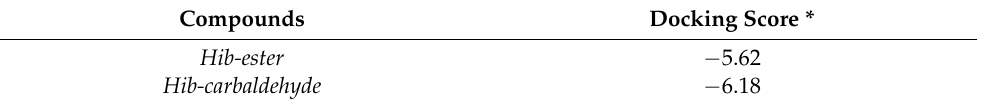
Table 1. Docking score values calculated for the two Hibiscus sabdariffa metabolites in complex with the